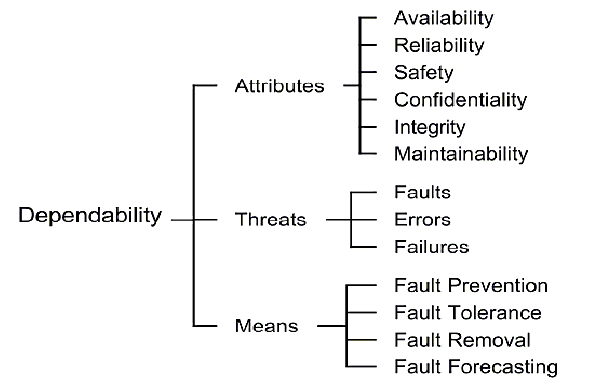
Fig. 1. Dependability